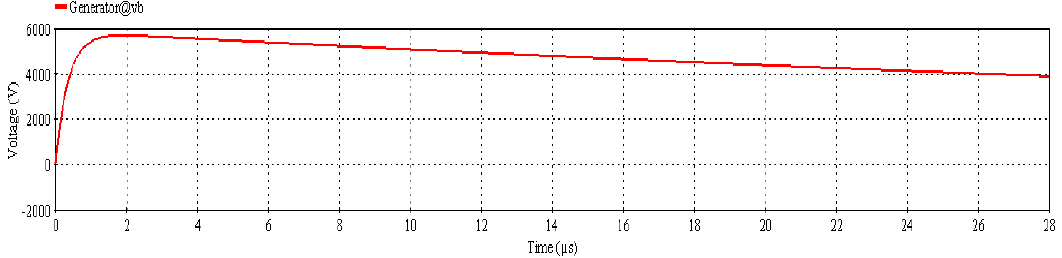
Figure 12. The open-circuit voltage waveform of 6 kV.